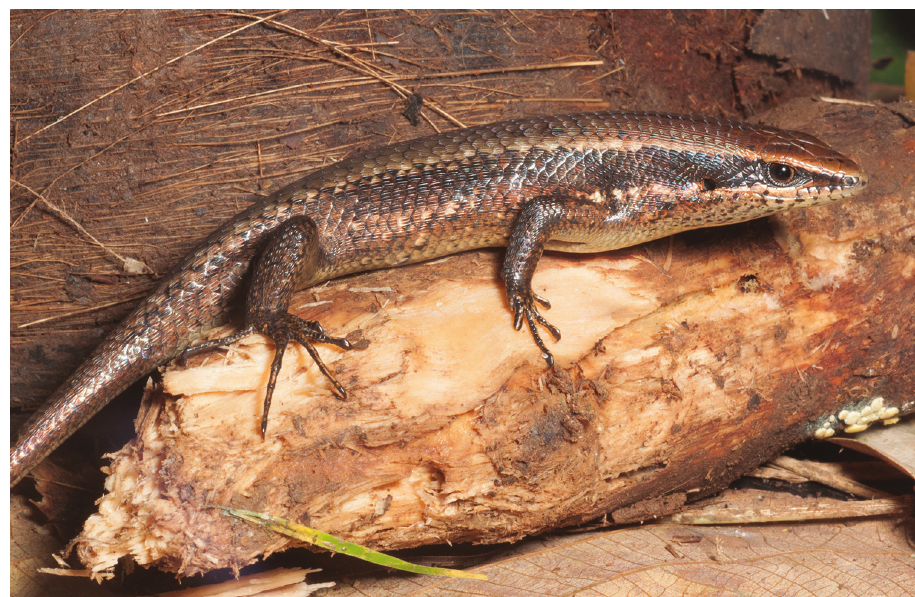
Figure 53. Eutropis multicarinata female (KU 334227) from Mt. Lumot, Municipality of Gingoog City, Misamis Oriental Province. Photo: